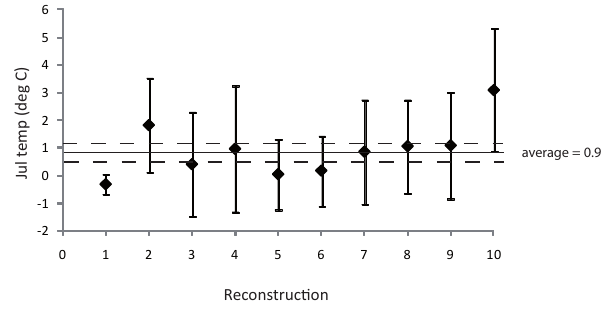
Fig. 7. Change in summer temperature between 6ka and 0.5ka from 10 reconstructions in the Abisko area, northern Sweden (diamonds) and their average (solid horizontal line). Error bars ( ± 2 σ comb ) for each reconstruction and for their average ( ± 2 σ comb , ave ; dotted lines) are indicated. (1) Tornetr¨ask, tree-ring width, (2) Vuoskkujavri, chironomids, (3) Vuoskkujavri, diatoms, (4) Vuoskkujavri, pollen, (5) Lake 850, chironomids, (6) Lake 850, diatoms, (7) Lake Njulla, diatoms, (8) Lake Njulla, chironomids, (9)Voulep Njakajaure, diatoms, (10) Lake Tibetanus, pollen. Note that all the reconstructions are reconstructions of July tempera- ture except the tree-ring reconstruction which is a reconstruction of June-August temperature. See Table 1a for references to the